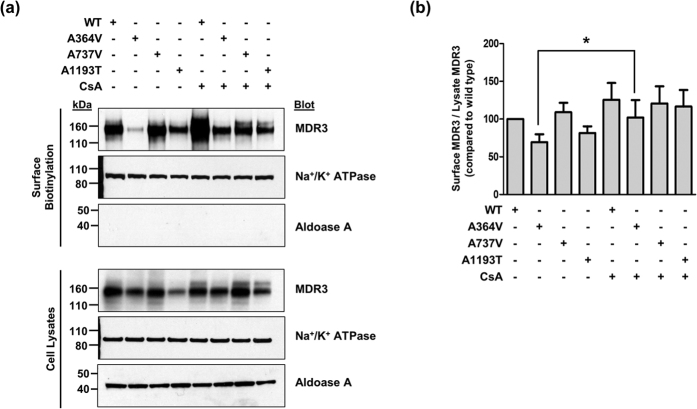
Effect of ABCB4 mutants and cyclosporin A (CsA) on the surface expression of MDR3.(a) HEK-293T cells transfected with ABCB4 wild type or mutant plasmids, and surface biotinylated. CsA was treated at 10 μM for 24 hours. Absence of the cytosolic protein aldolase A in the biotinylated fraction confirms cell surface protein-specific labeling in each experiment. (b) Quantification of surface expression of MDR3. Bar graphs represent band density of surface biotinylated MDR3 compared to the wild type ABCB4 and error bars indicate the SD for three independent experiments. *P < 0.05, Student’s t test.